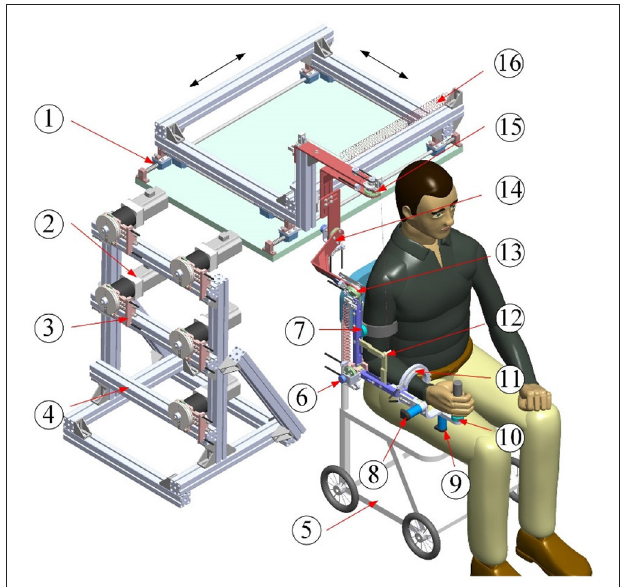
FIGURE 1 | Architecture of upper limb rehabilitation exoskeleton (1-Self-aligning platform; 2-AC servo motor; 3-Bowden cable components; 4-Support frame; 5-Wheelchair; 6-Elbow flexion/extension; 7-Proximal force/torque sensor; 8-Wrist flexion/extension; 9-Wrist ulnal/radial deviation; 10-Distal force/torque sensor; 11-Forearm pronation/supination; 12-Auxiliary links; 13-Shoulder flexion/extension; 14-Shoulder abduction/adduction; 15-Shoulder internal/external; 16-Free-length spring).